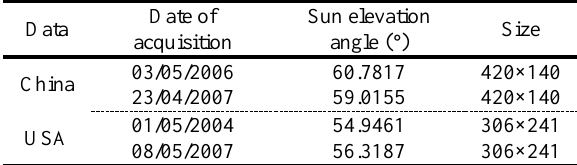
Table 1. The description of hyperspectral image